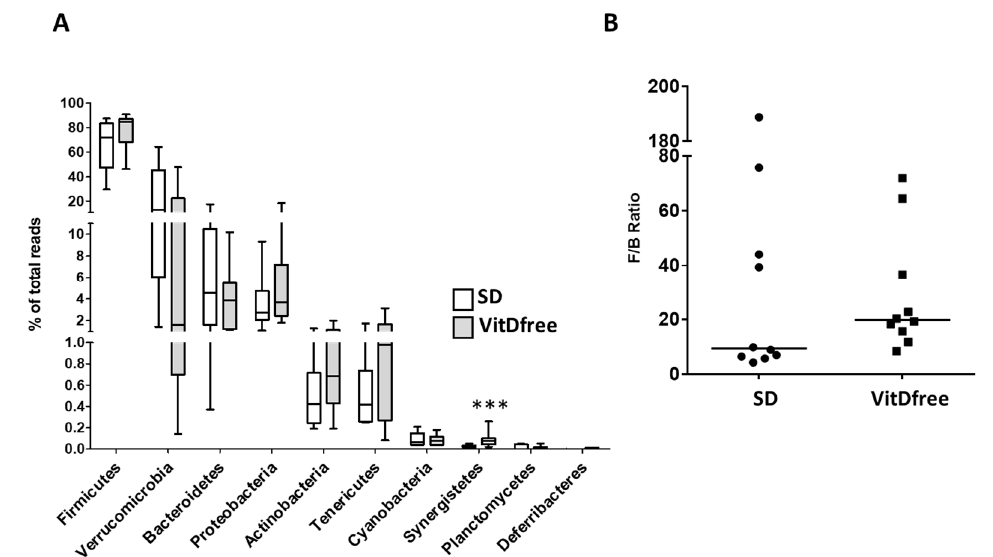
Figure 4. Effects of the vitamin D-free diet on the relative phylum abundance. The most abundant phyla for the standard diet (SD, n = 10) and vitamin D-free diet group ( n = 10) were expressed as a percent of total reads and represented in ( A ) as a box and whiskers plot, *** p < 0.001 vs. SD, student’s t-test. ( B ) Firmicutes to Bacteroidetes ratio (F/B ratio), as a biomarker of gut dysbiosis, is represented as a scatterplot and median.